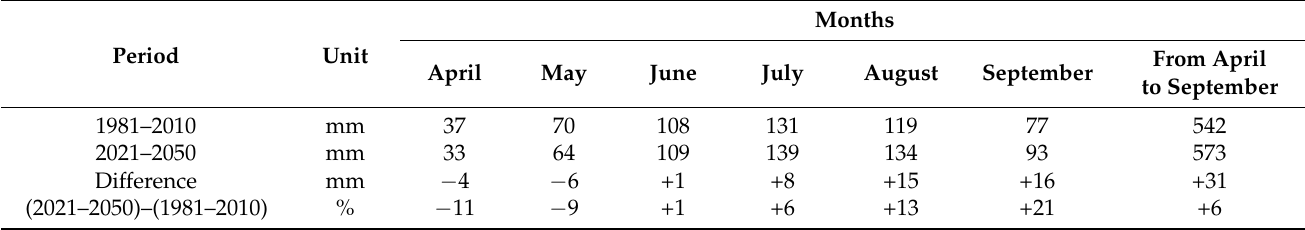
Table 4. Comparison of the water needs of sweet cherry trees in 1981–2010 and